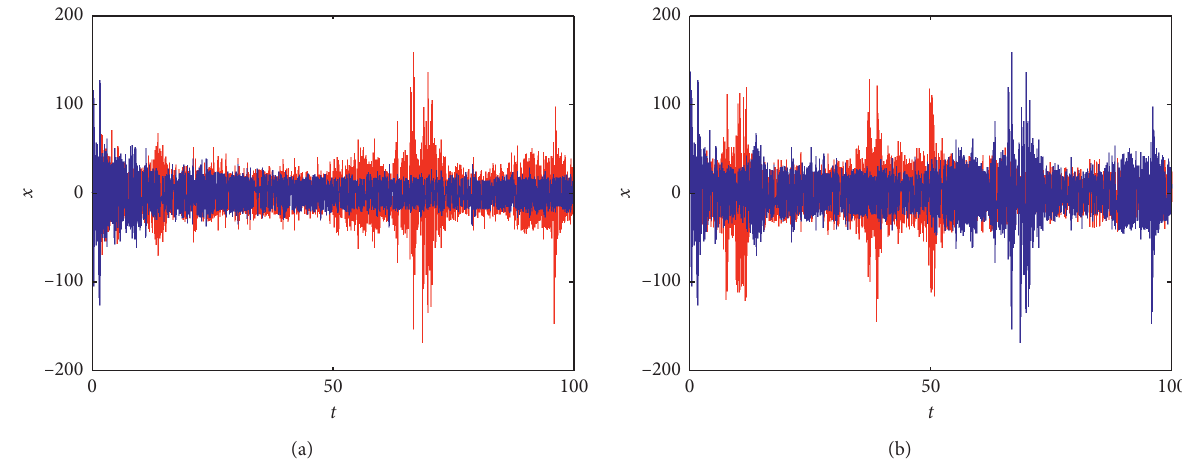
+ 10 − 12 (blue). (b) The initial conditions x (red) and a 1 1